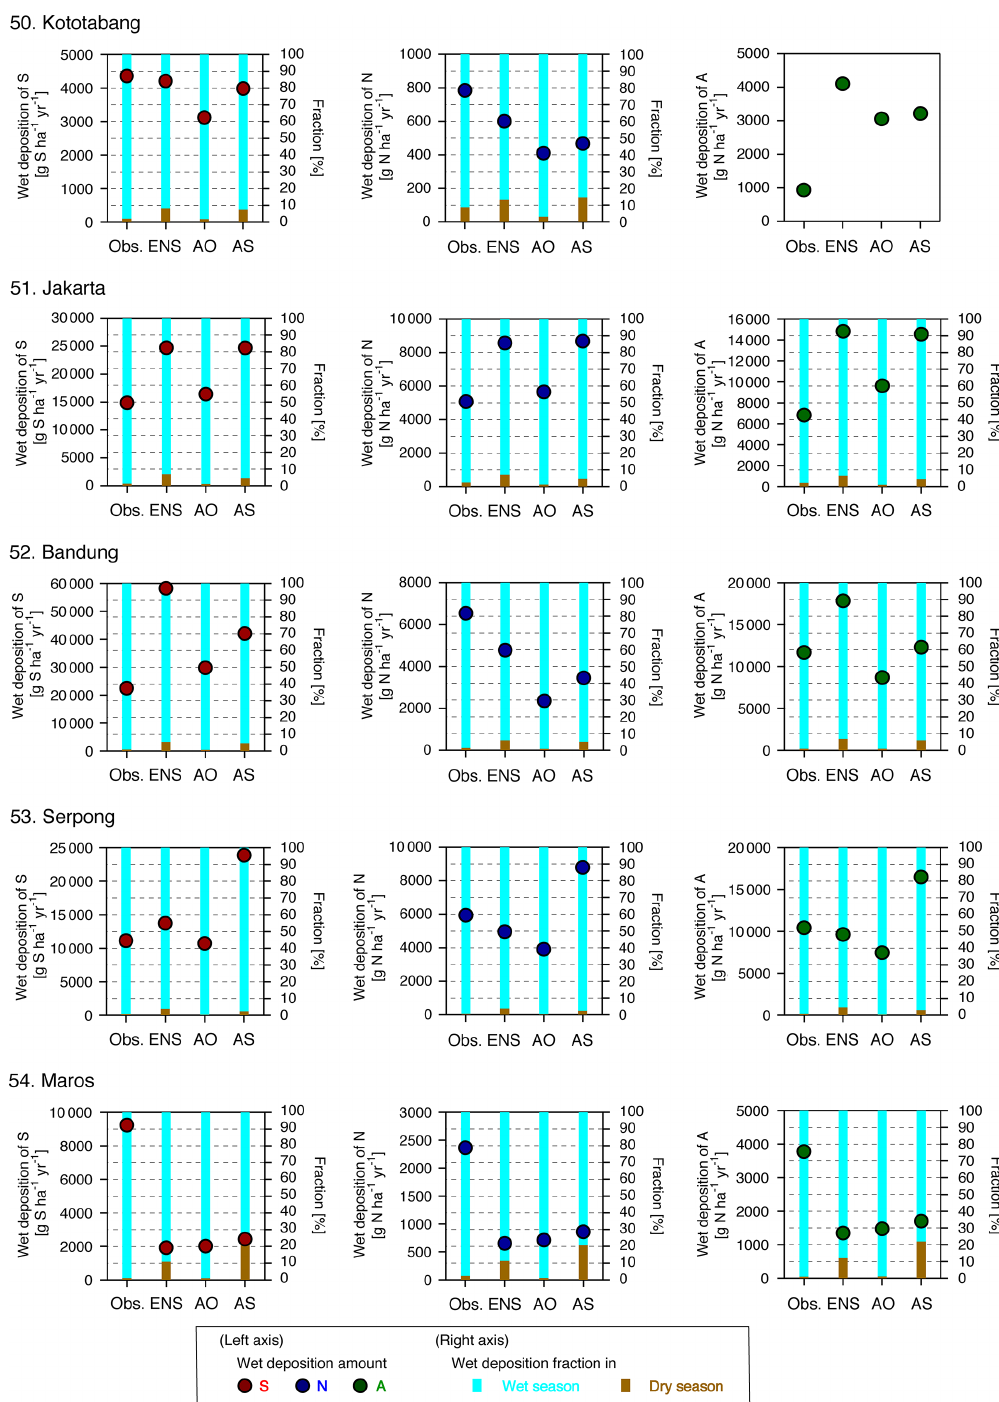
Figure 16. Observed and simulated annual accumulated wet deposition amounts of S, N, and A, and the fraction of wet deposition during the wet and dry seasons at five sites in Indonesia. The annual accumulated wet deposition amount is based on the months for which wet deposition observations were available (see Fig.